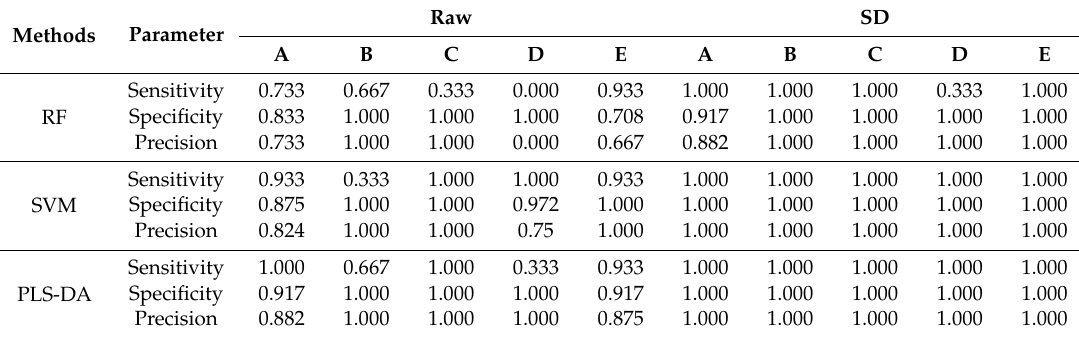
Table 4. Parameters of merit for the classification of Lingzhi using ATR-FTIR spectrum after applying di ff erent chemometric methods and spectra